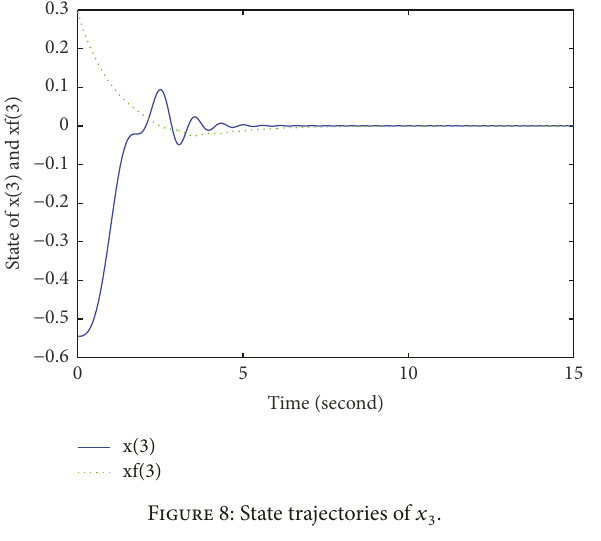
Figure 8: State trajectories of 𝑥 3 .